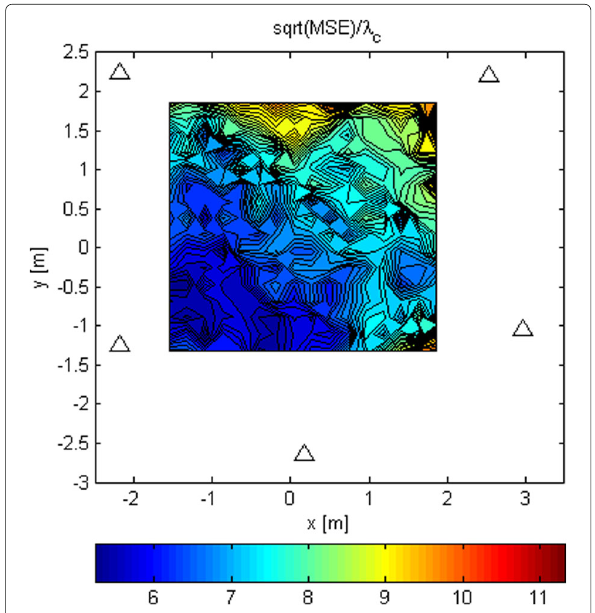
Fig. 15 RMSE/ λ c for stage 2 for G 2 and N =